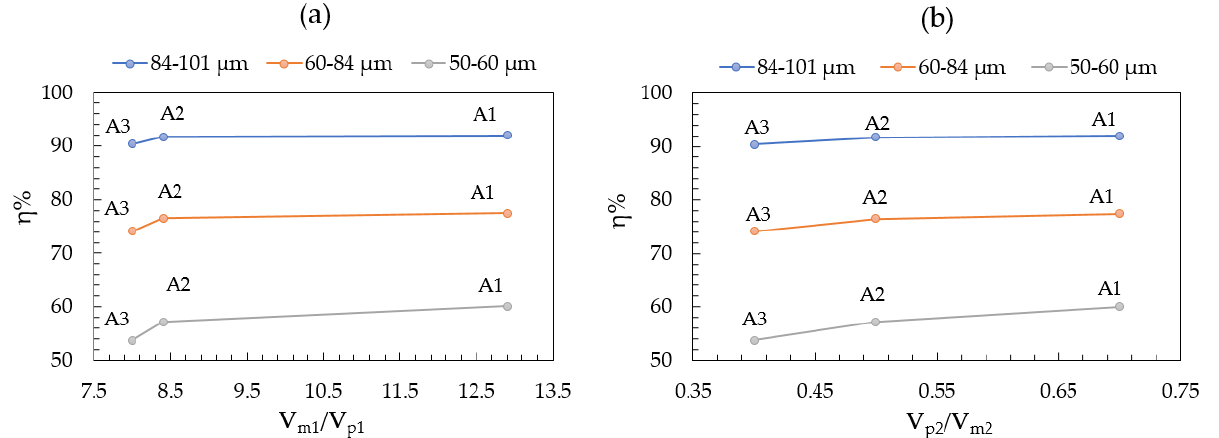
Figure 5. The relationship between ( a ) V m1 / V p1 in inlet tank and inclusion removal rate; ( b ) V p2 / V m2 in outlet tank and inclusion removal rate for Cases A1, A2 and A3.